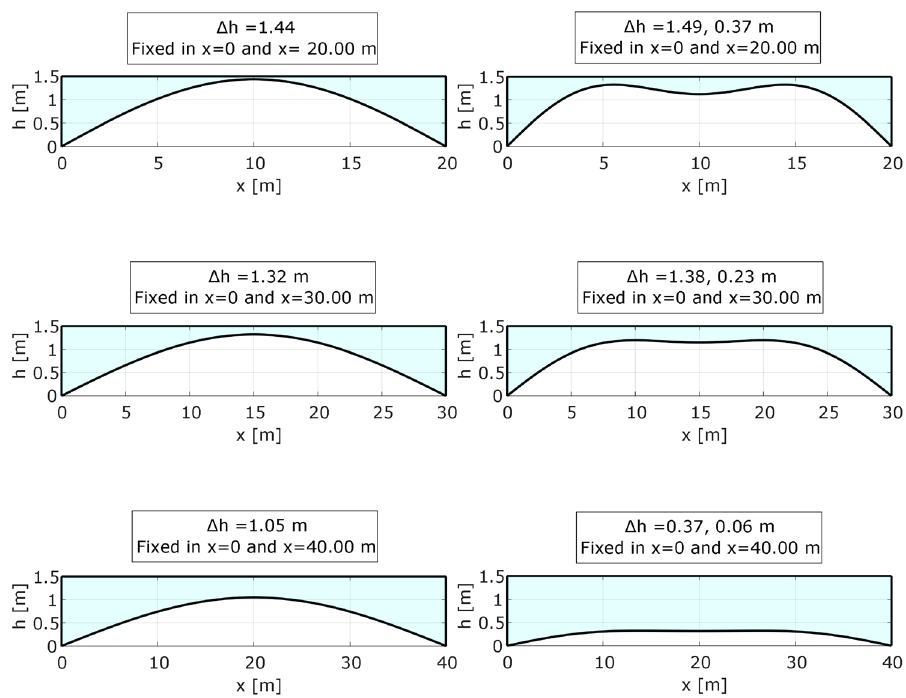
Fig. 7 Optimal results obtained by the GA algo- rithm with a population of 20 individuals and maximum iterations allowed of 50, adopting the dog-bone Matlab models for three hypothetical span length L = 20,30,40 m . The left column illustrates the optimal results adopting one lobe sine emptying function, whereas the right column contains the optimal results obtained with three lobes sine emptying function